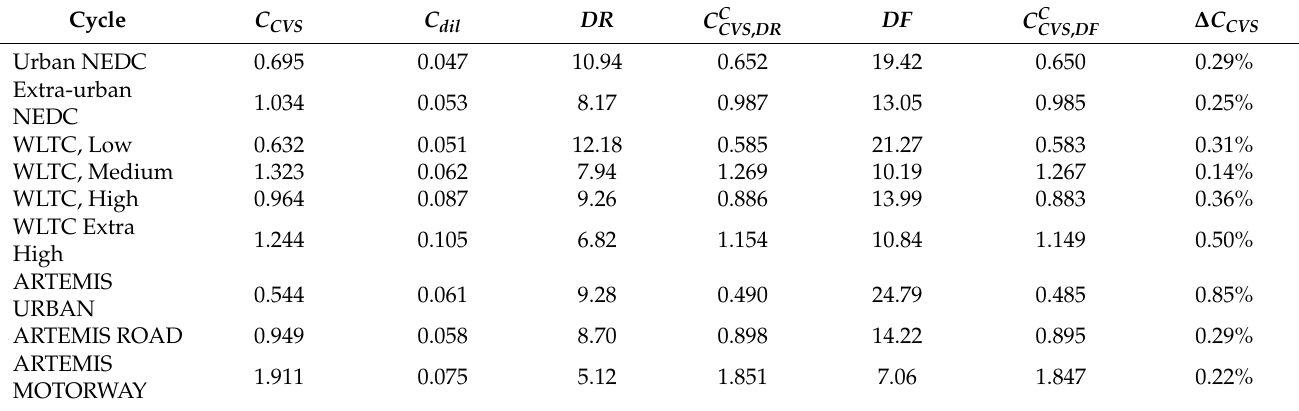
Table A1. The C CVS,corr calculated based on Equations (5) and (21) for Euro 5 vehicle with CI engine, CO 2 pollutant [%].